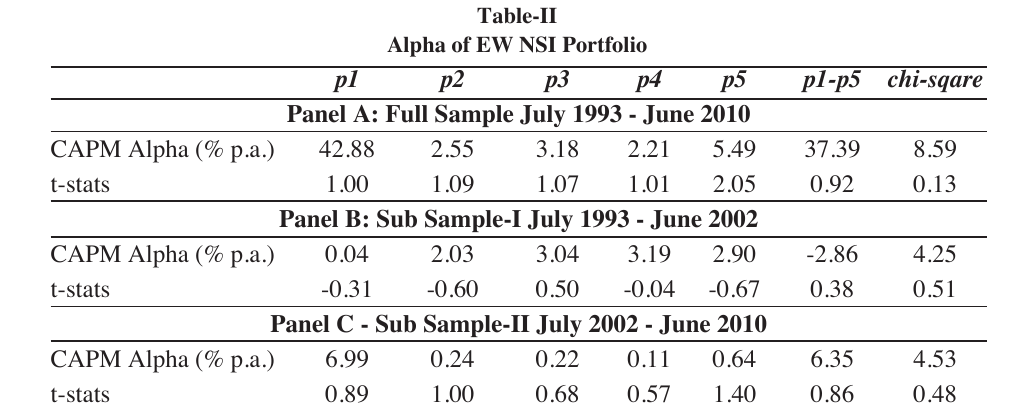
Alpha of EW NSI